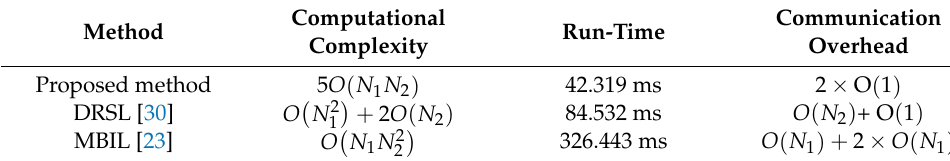
Figure 10. The average positioning time of each node under different numbers of neighbor nodes. Table 2. Comparisons of different methods for each node at each iteration.